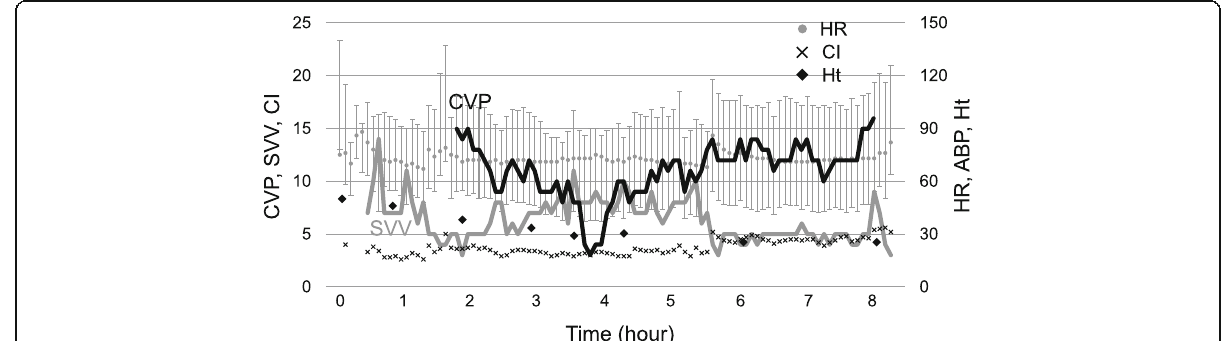
Fig. 1 Intraoperative changes of hemodynamic parameters. Changes in CVP ( black line ) and SVV ( gray line ). High and low lines show systolic and diastolic blood pressure. CVP = central venous pressure, SVV = stroke volume variation, CI = cardiac index, HR = heart rate, ABP = arterial blood pressure, Ht =